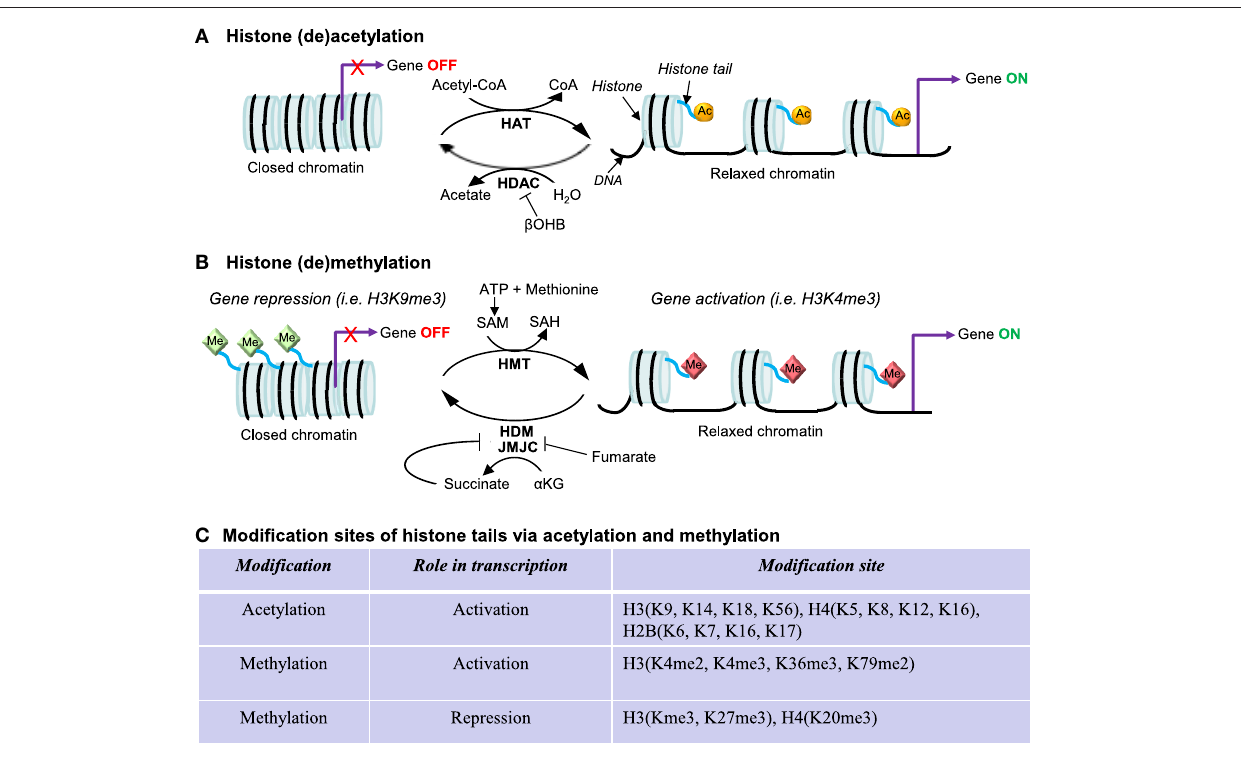
FIGURE 3 | Regulation in gene expression via histone acetylation and methylation. The protruding amino tails of histone proteins can undergo post-translational modifications that affect the expression of genes in close proximity. (A) Histone acetylation and deacetylation. Histone lysines are acetylated by histone acetyltransferases (HATs), which use acetyl-CoA as a cosubstrate. Histone deacetylases (HDACs) are grouped in four classes: Classes I, II, and IV are Zn 2 + -dependent and release acetate as a coproduct while sirtuins (class II HDACs) consume NAD + and produce nicotinamide and O-acetyl-ADP-ribose. β -hydroxybutyrate ( β OHB) is a ketone body and can inhibit class I and IIa HDACs, being structurally related to be well-known HDAC inhibitor butyrate ( 95). (B) Histone methylation and demethylation. Histones are methylated by histone methyltransferases (HMTs), which require S-adenosylmethionine (SAM) as a consubstrate, yielding S-adenosylhomocysteine (SAH), which is subsequently hydrolyzed to homocysteine and adenosine by SAH-hydrolase ( 96) Two classes of histone demethylases (HDMs) can remove a methyl group: Lysine-specific demethylase 1 (LSD1) requires the reduction of flavin adenine dinucleotide (FAD) (97), while the Jumonji C (JMJC) domain-containing lysine demethylases catalyze a different demethylation reaction that requires α -ketoglutarate ( α KG), O 2 , and Fe(II) ( 98). Fumarate and succinate, the intermediates in the TCA cycle, are the competitive inhibitors ( 99, 100). (C) Summary of modification sites of histone tails via acetylation and methylation. Other histone post-translational modifications include phosphorylation, ubiquitination, SUMOylation, ADP-ribosylation citrullination, and